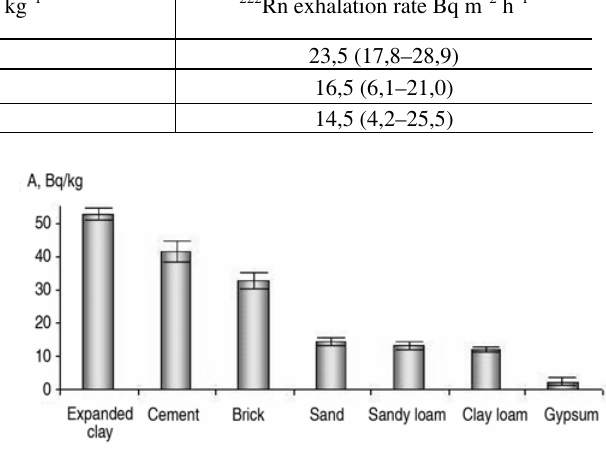
Table 3 . Average 226 Ra concentration and average 222 Rn exhalation rate with variation (minimum-maximum) in different types of soil Soil type